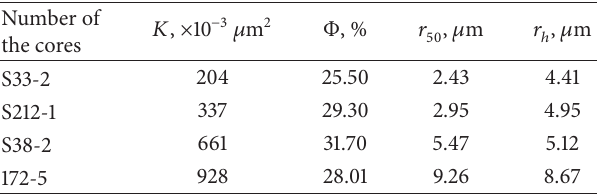
Table 3: The core parameters.